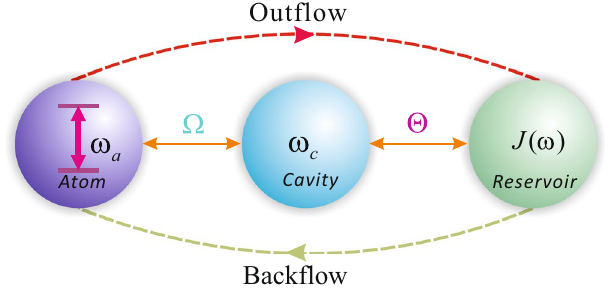
Figure 1. A schematic of information flow within the composite system consisting of the atom, single-mode cavity and reservoir with Lorentz spectrum ω J ( ) . Explicitly, the atom is coupled with the cavity by coupling constant, Ω , and the cavity is coupled with a structured reservoir with an additional coupling constant, Θ